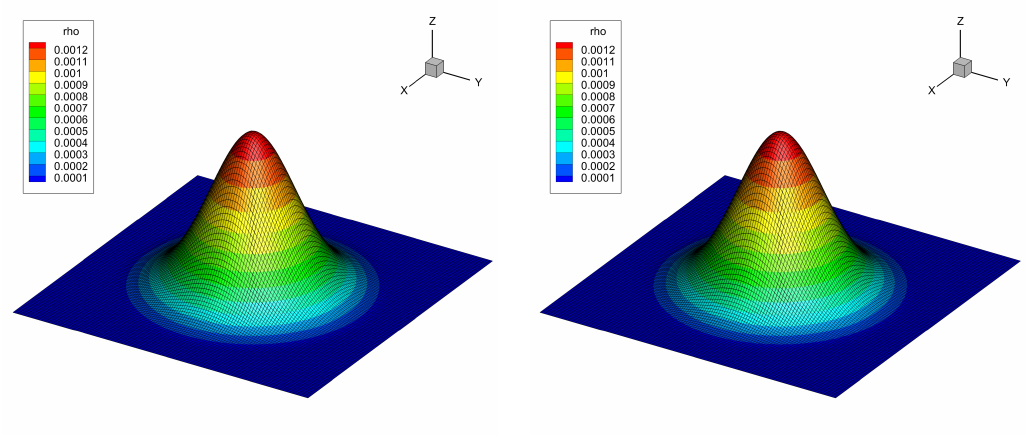
Figure 9. Computational results for a stable 3D neutron star. Cut through the x – y plane with pressure on the z axis and rest mass density contour colors. Exact solution ( left ) and numerical solution at time t = 1000 ( right